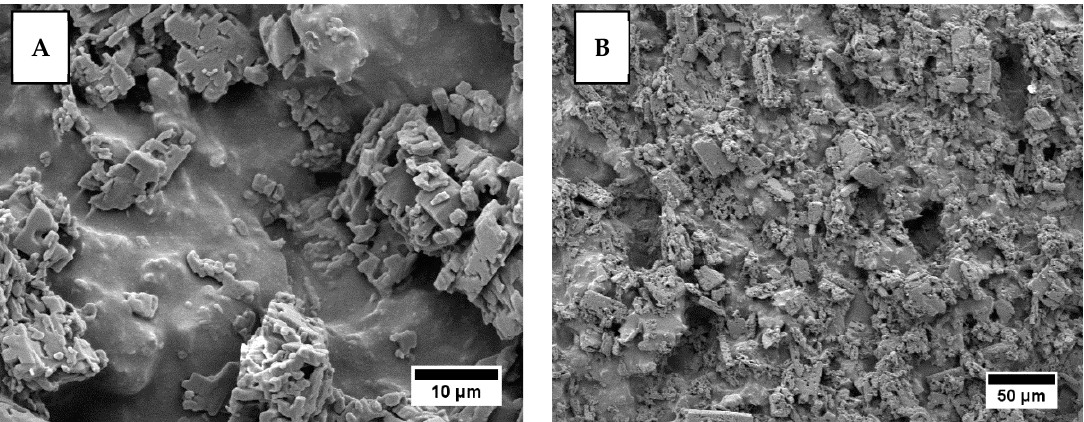
Figure 5. SEM images at two magnifications of chitosan/curcumin coatings produced by EPD on 316L SS at 20 V and 3 min: ( A ) 500× and ( B ) 5000×.